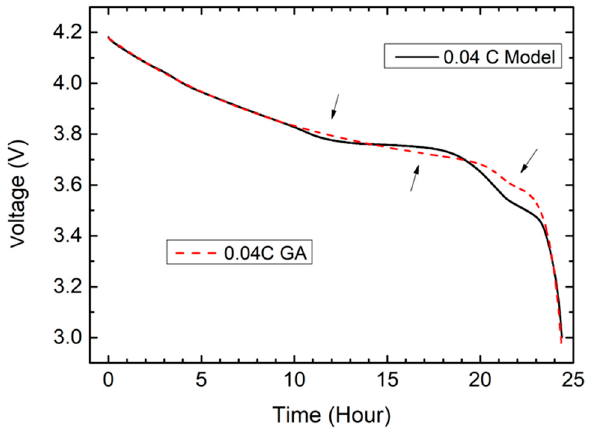
Figure 17. GA results (L brand 18650).